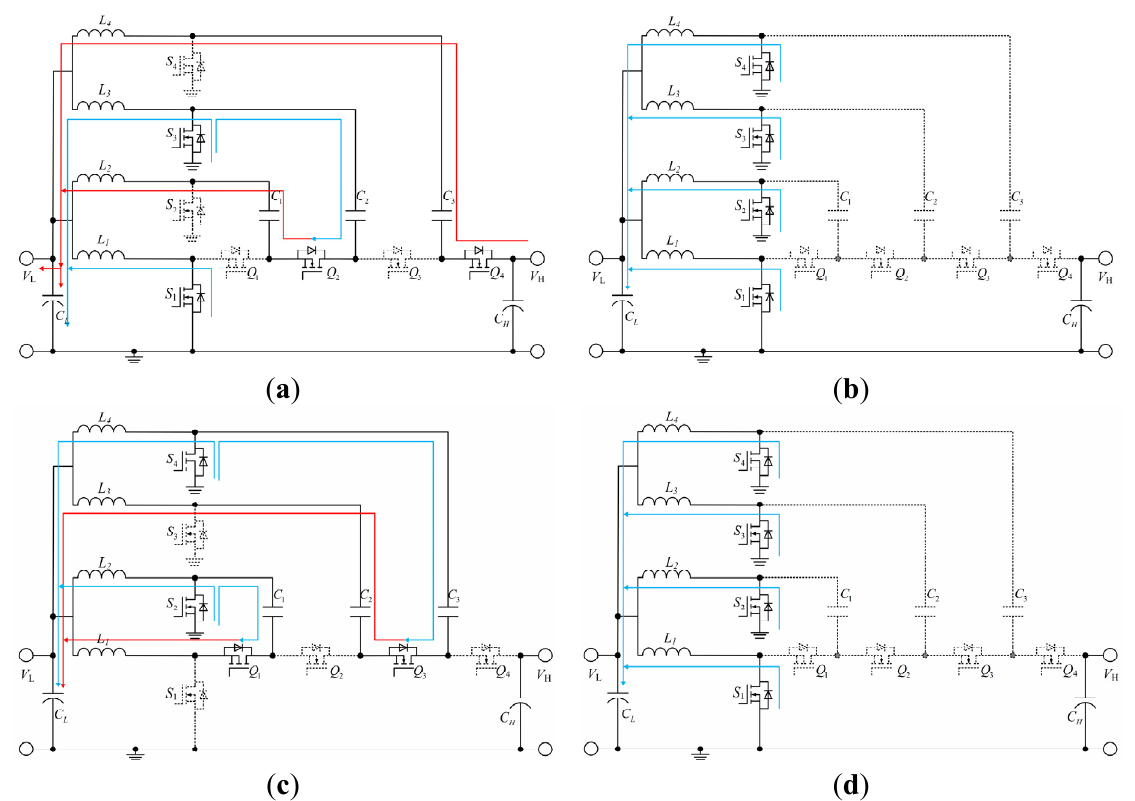
Figure 11. Equivalent circuits in CCM Buck stage ( a ) interval 1; ( b ) interval 2; ( c ) interval 3; ( d ) interval